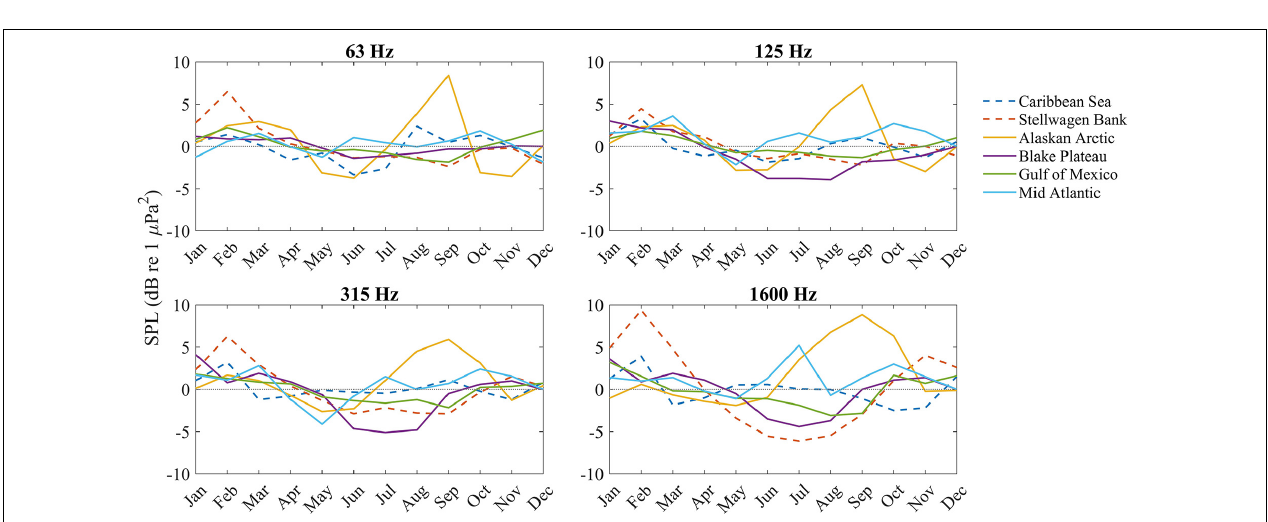
FIGURE 3 | Median (50th percentile) spectrum levels (line) for each hourly decidecade band by site. Dashed lines indicate a shallow water site ( < 200 m) while solid lines indicate a mid ( > 200 and < 400 m) or deep ( > 400 m) water site. The shaded regions represent the 10th (lower) and 90th (upper) percentiles of each decidecade band. Spectrum levels are limited by each site’s sample rate and therefore do not span all frequencies in the x-axis. Note the x-axis shows the decidecade band and is therefore non-linear.